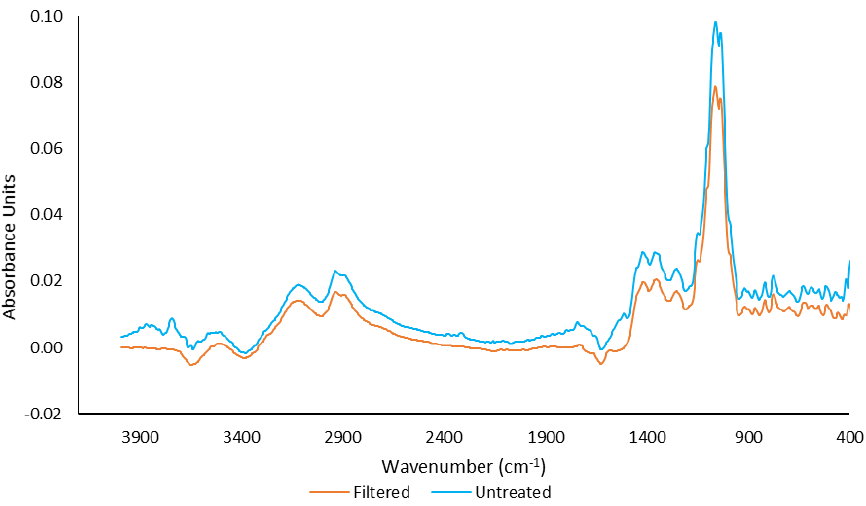
Figure 1. Average filtered and untreated spectra for ATR-FT-MIR spectroscopy.